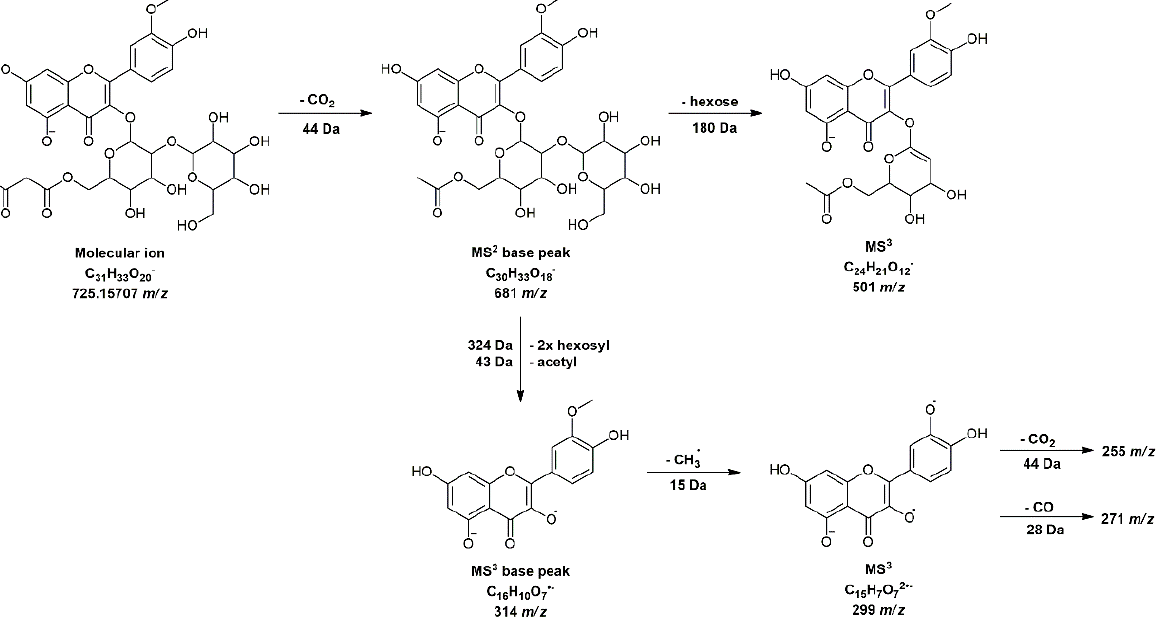
Figure A2. Fragmentation pathway of patuletin 3- O -(6 ″ -malonyl)-hexoside (compound 20). References 1. Hancock, J.F.; Lobos, G.A. Pears. In Temperate Fruit Crop Breeding: Germplasm to Genomics ; Hancock, J.F., Eds.; Springer: Dor- drecht, The Netherlands, 2008; pp. 299 − 335. https://doi.org/10.1007/978-1-4020-6907-9_10.